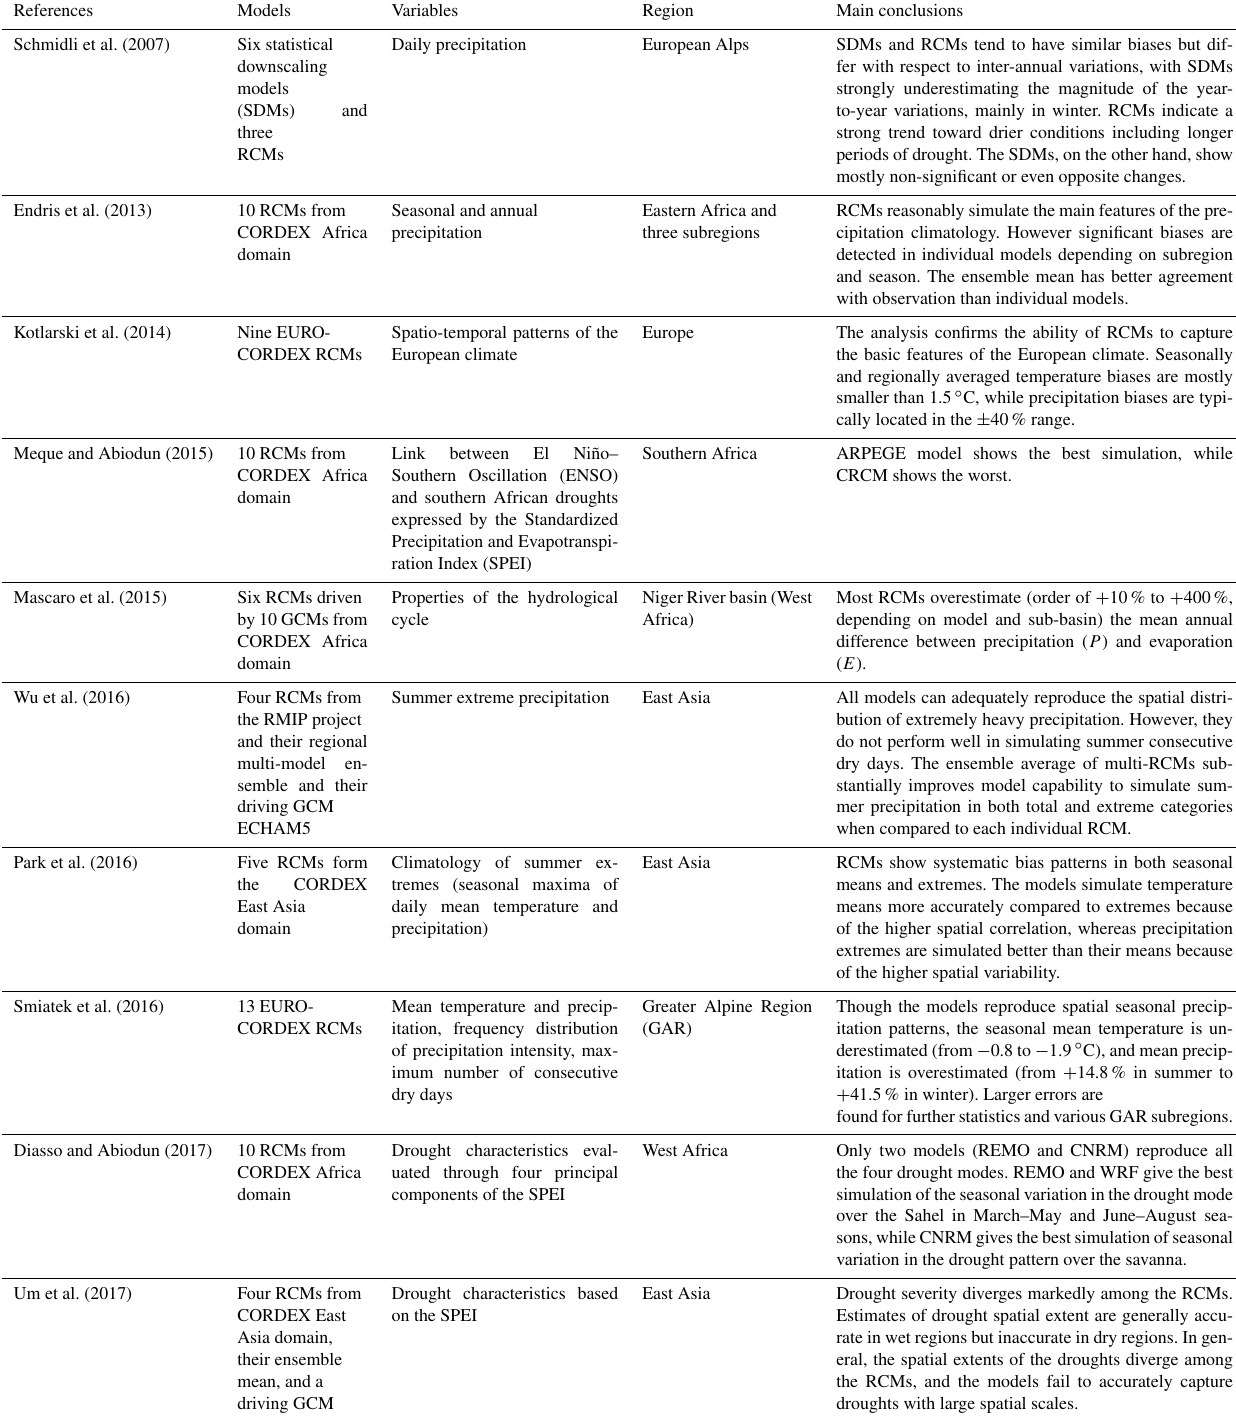
Table 1. Inter-comparison studies of RCM performances within the CORDEX